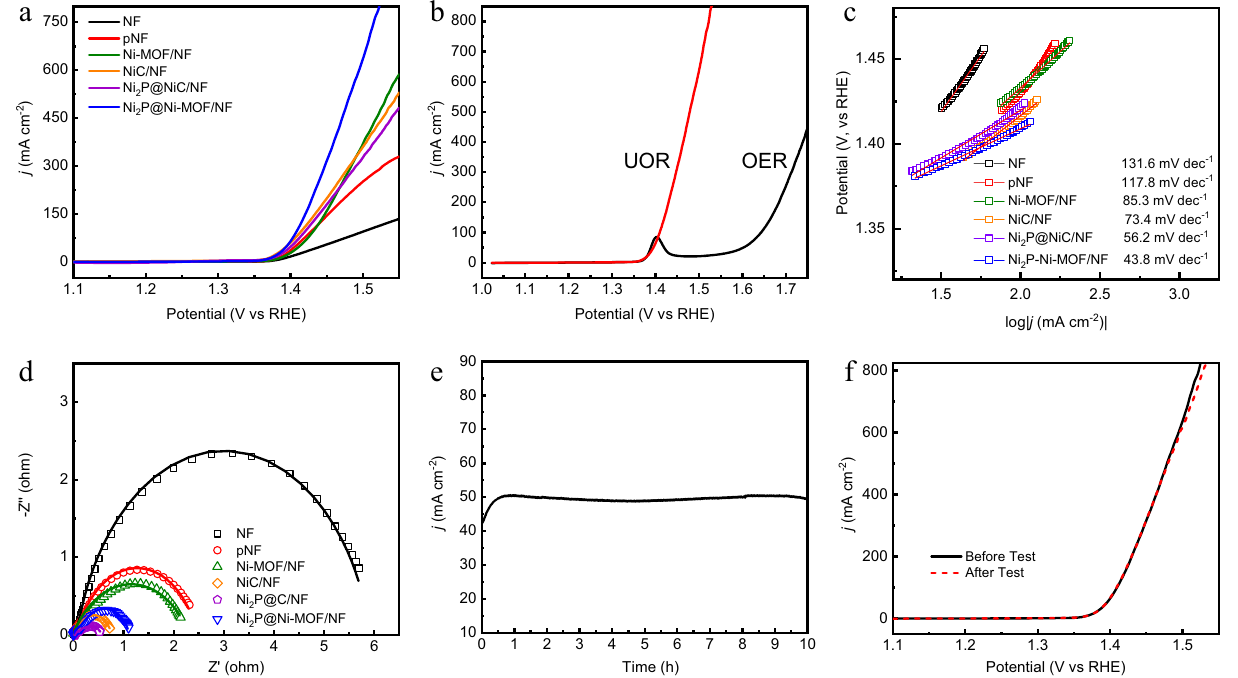
Figure 5. ( a ) LSV curves of Ni 2 P@Ni-MOF/NF, Ni 2 P@NiC/NF, NiC/NF, Ni-MOF/NF, pNF and NF in 1.0 M NaOH with 0.33 M urea. ( b ) LSV curve of Ni 2 P@Ni-MOF/NF in 1.0 M NaOH with or without 0.33 M urea. ( c ) The corresponding Tafel plots and ( d ) the Nyquist plots of various electrodes. ( e ) Chronoamperometric (i-t) curve of